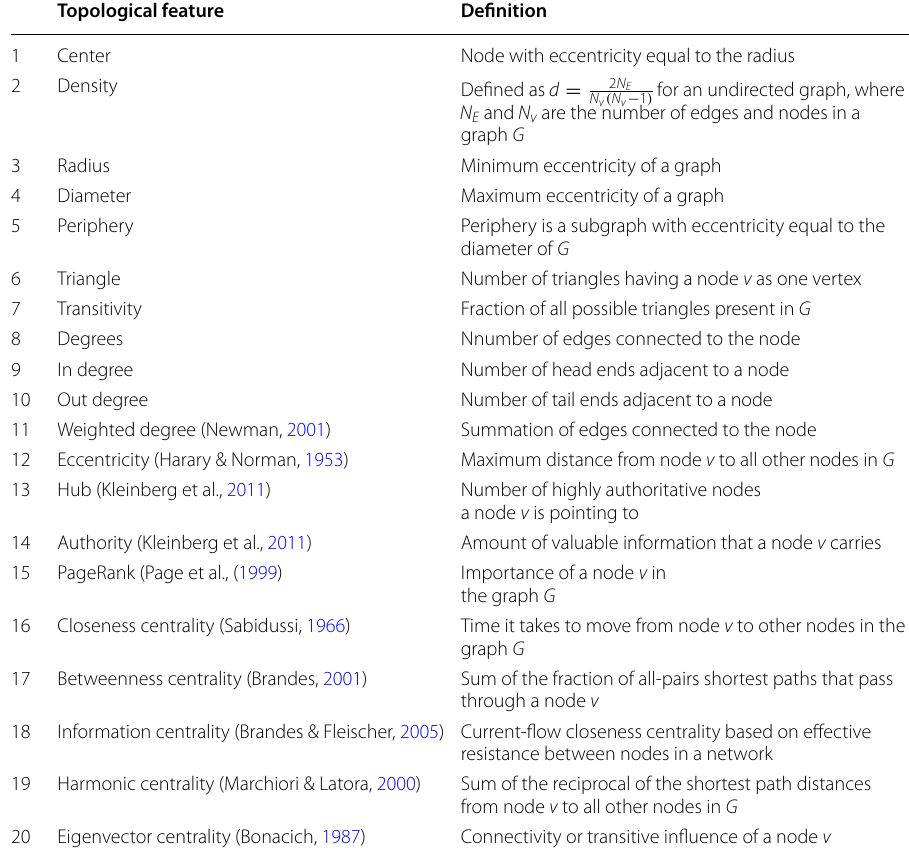
Table 4 Definitions of topological features in graph theory Topological feature